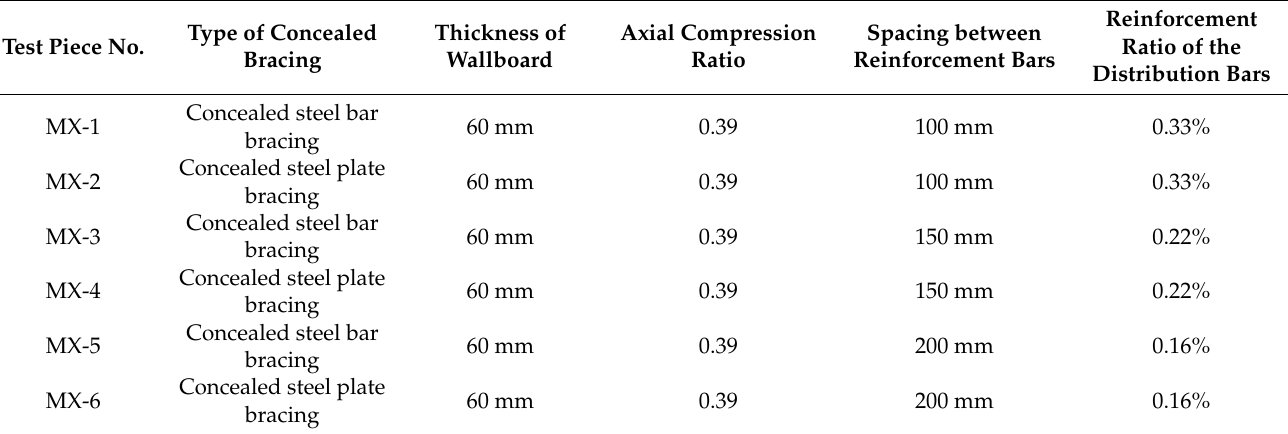
Table 1. Design parameters of the composite shear wall.